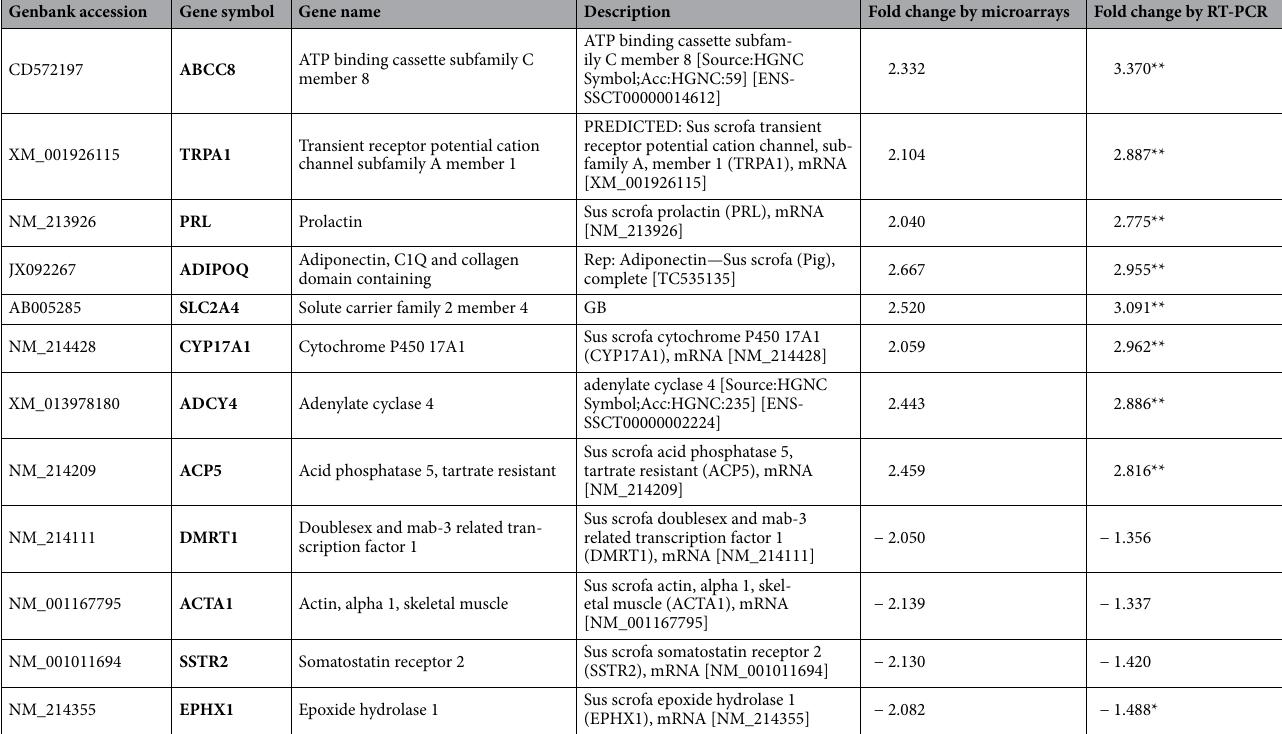
Table 11. The expression profiles of selected genes from microarray and RT-PCR. Positive number indicates elevated expression (fold) in the meniscus of the experimental group (Ba group) compared to the meniscus of the control group (Aa group). Negative number indicates decreased expression (fold) in the meniscus of the experimental group (Ba group) compared to the meniscus of the control group (Aa group). *p < 0.05, **p < 0.01 (versus sham-operated